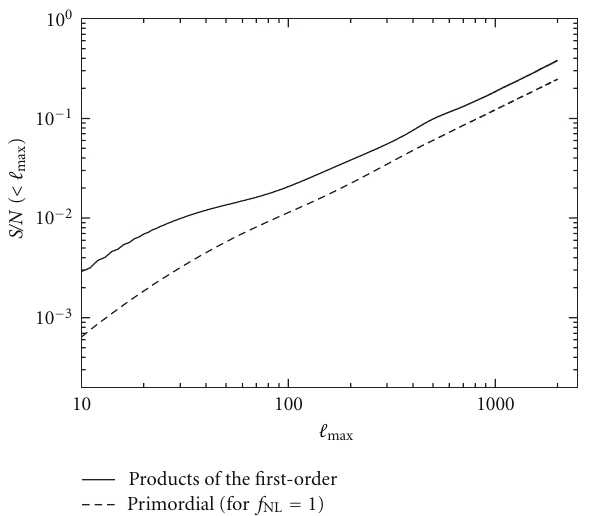
Figure 3: Signal-to-noise ratios for the local primordial bispectrum for f NL = 1 (dashed), and the second-order bispectrum from the products of the first-order terms (solid), for an ideal full-sky and cosmic-variance-limited (noiseless)